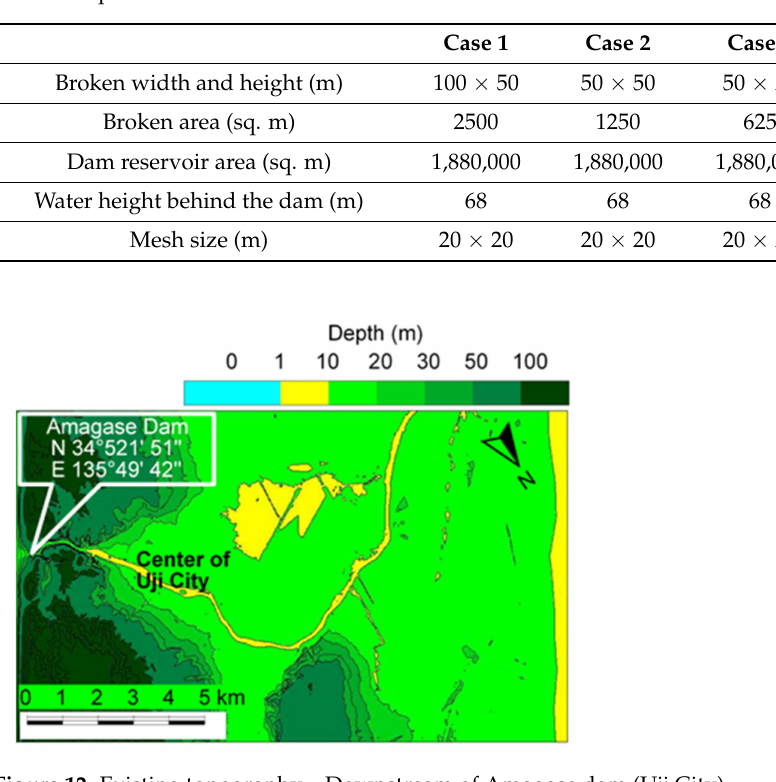
Figure 12. Existing topography—Downstream of Amagase dam (Uji City).